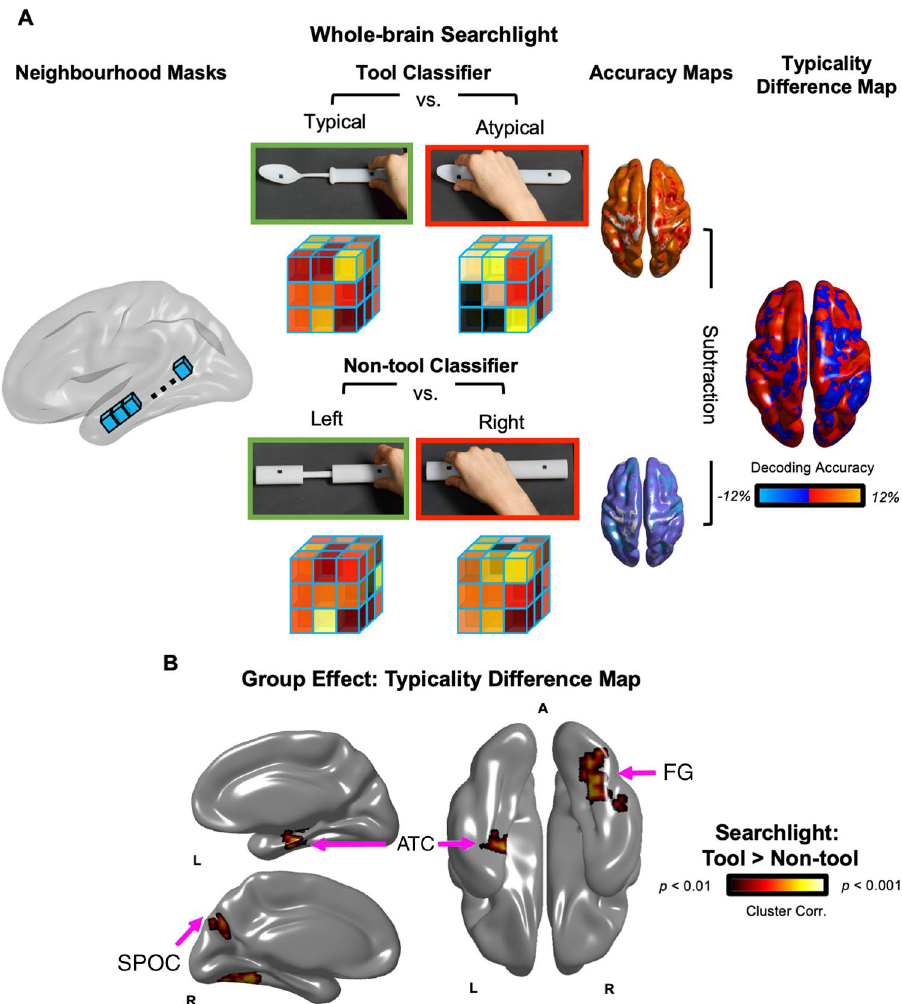
Figure 2. ( A ) Wholebrain searchlight classification . For each participant, brain activation patterns were extracted from a mask (single blue cube) that was shifted through the entire fMRI volume. Decoding accuracy was measured with independent linear pattern classifiers for tool (top row) and non-tool actions (bottom row) that were trained to map between brain-activity patterns and the type of grasp being performed with the tools (typical vs. atypical) or non-tools (right vs. left). Typicality difference maps were produced by subtracting the decoding accuracy maps for tools and non-tools, as well as chance-level accuracy (50%). ( B ) Searchlight Results . The group typicality difference map demonstrated clusters in the left anterior temporal cortex, as well as right medial parietal and fusiform areas, where decoding accuracies were significantly higher for actions with tools (typical vs. atypical grasps) than non-tools (biomechanically equivalent right vs. left grasps). Acronyms: ATC: Anterior Temporal Cortex; FG: Fusiform Gyrus; SPOC: Superior Parieto-Occipital Cortex.